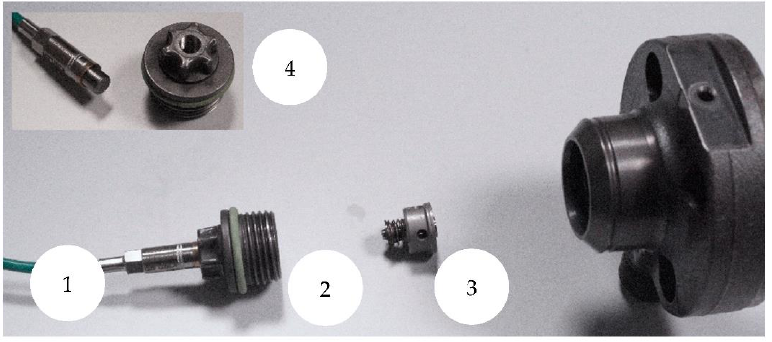
and the head-cover disassembled.